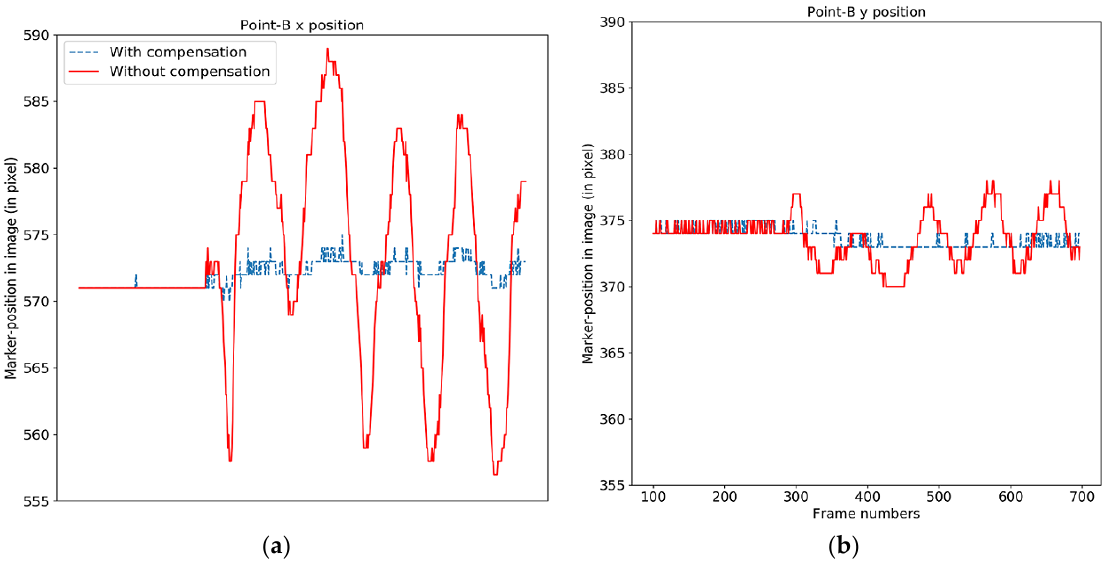
Figure 7. Electron micrograph without (red) and with (blue) progress compensation for corner y, shown for both the x-axis ( a ) and the y-axis ( b ). Table 3. Compensation results for each corner and average per class (APC).